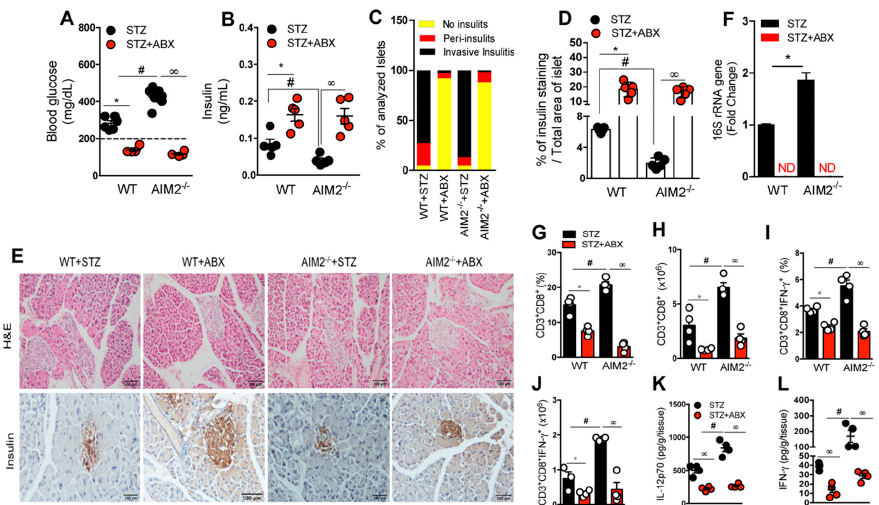
Figure 5. AIM2 receptor restrains gut microbiota translocation and controls the generation of a proinflammatory response in PLNs during T1D. The WT and AIM2 − / − mice were treated with an antibiotic cocktail (ABX) for 21 days before the STZ injections, and the clinical and immunological parameters were determined. ( A ) Blood glucose and ( B ) insulin levels in the serum of the WT and AIM2 − / − mice at 15 days after the vehicle and STZ injections. ( C ) Score of the inflammatory infiltrates in the islets of the WT and AIM2 − / − mice at 15 days after the vehicle and STZ injections or after the ABX and STZ injections. ( D ) Quantification of insulin in the pancreatic tissue of the WT and AIM2 − / − mice at 15 days after the STZ injections. ( E ) Histopathology and insulin staining, assessed by immunohistochemistry, in the pancreatic tissue of the WT and AIM2 − / − mice at 15 days after the vehicle and STZ injections or after the ABX and STZ injections. ( F ) The 16S rRNA gene expression in the PLNs of the WT and AIM2 − / − mice at 15 days after the STZ injections. ( G – J ) The percentage and absolute numbers of CD3 + CD8 + and CD3 + CD8 + IFN- γ + cells in the PLNs of the WT and AIM2 − / − mice at 15 days after the STZ injections. ( K , L ) The protein levels of IL-12 p70 and IFN- γ cytokines, assessed by ELISA, in the pancreatic tissue of the WT and AIM2 − / − mice at 15 days after the STZ injections. The values are expressed as the mean ± SD. The results are considered statistically significant when p < 0.05 (*; #, ∞ ). N = 3–6 animals per group. Significant differences between the groups were determined by one-way ANOVA, followed by Tukey’s multiple-comparison test.